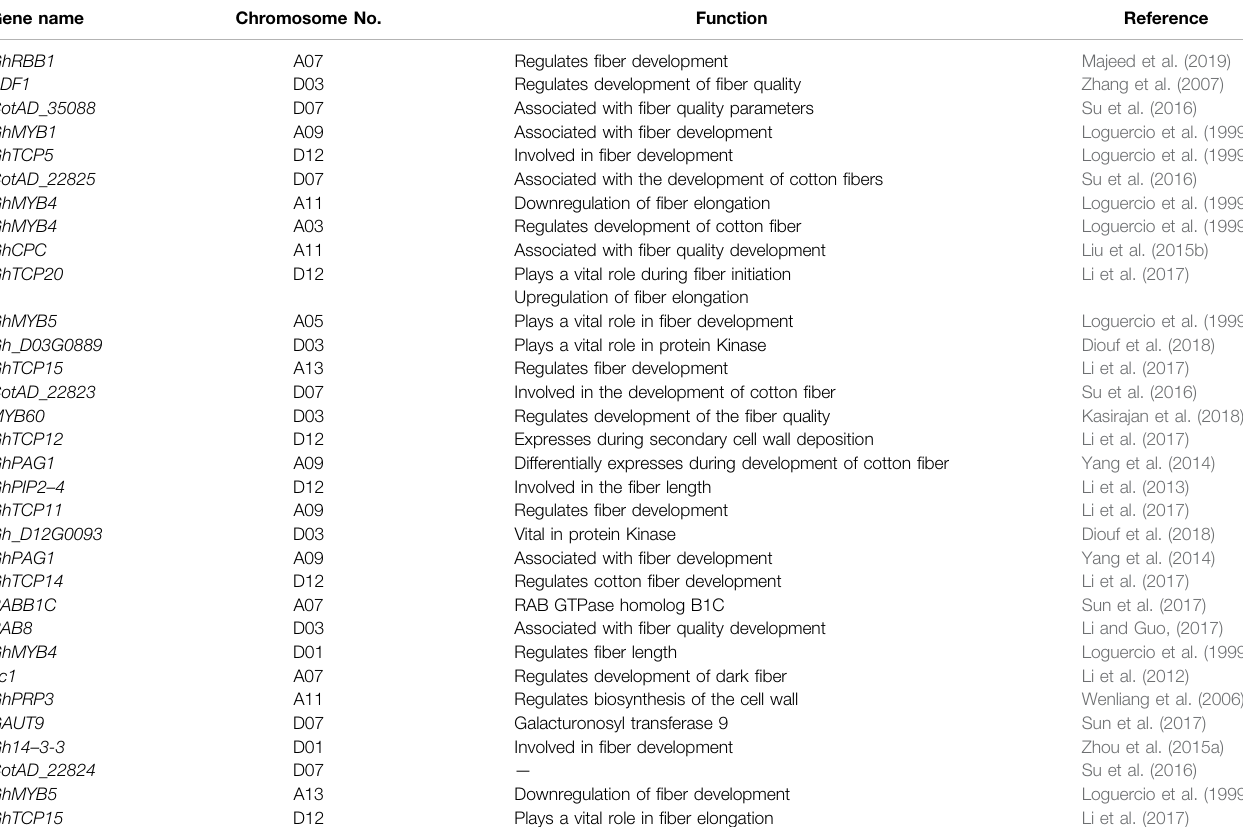
TABLE 2 | Fiber quality development genes across the whole genome of G. hirsutum